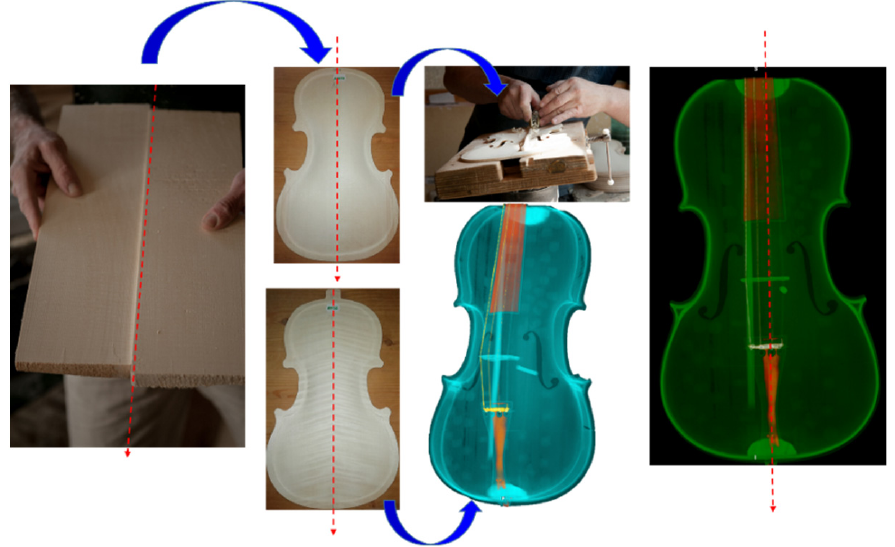
Figure 1. Symmetrical and asymmetrical systems: the violin—anatomical symmetry of the wood and constructive asymmetry of the body.